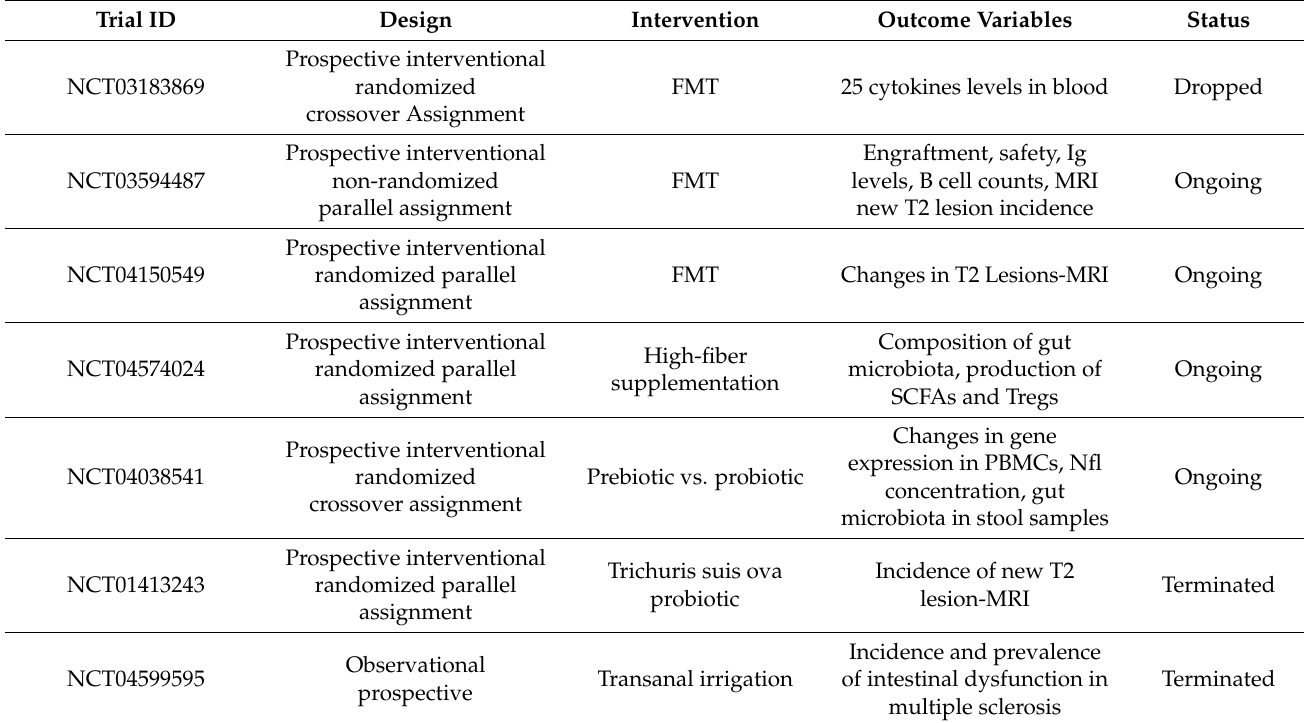
Table 2. Reported clinical trials assessing the effects of gut microbiota modulation in multiple